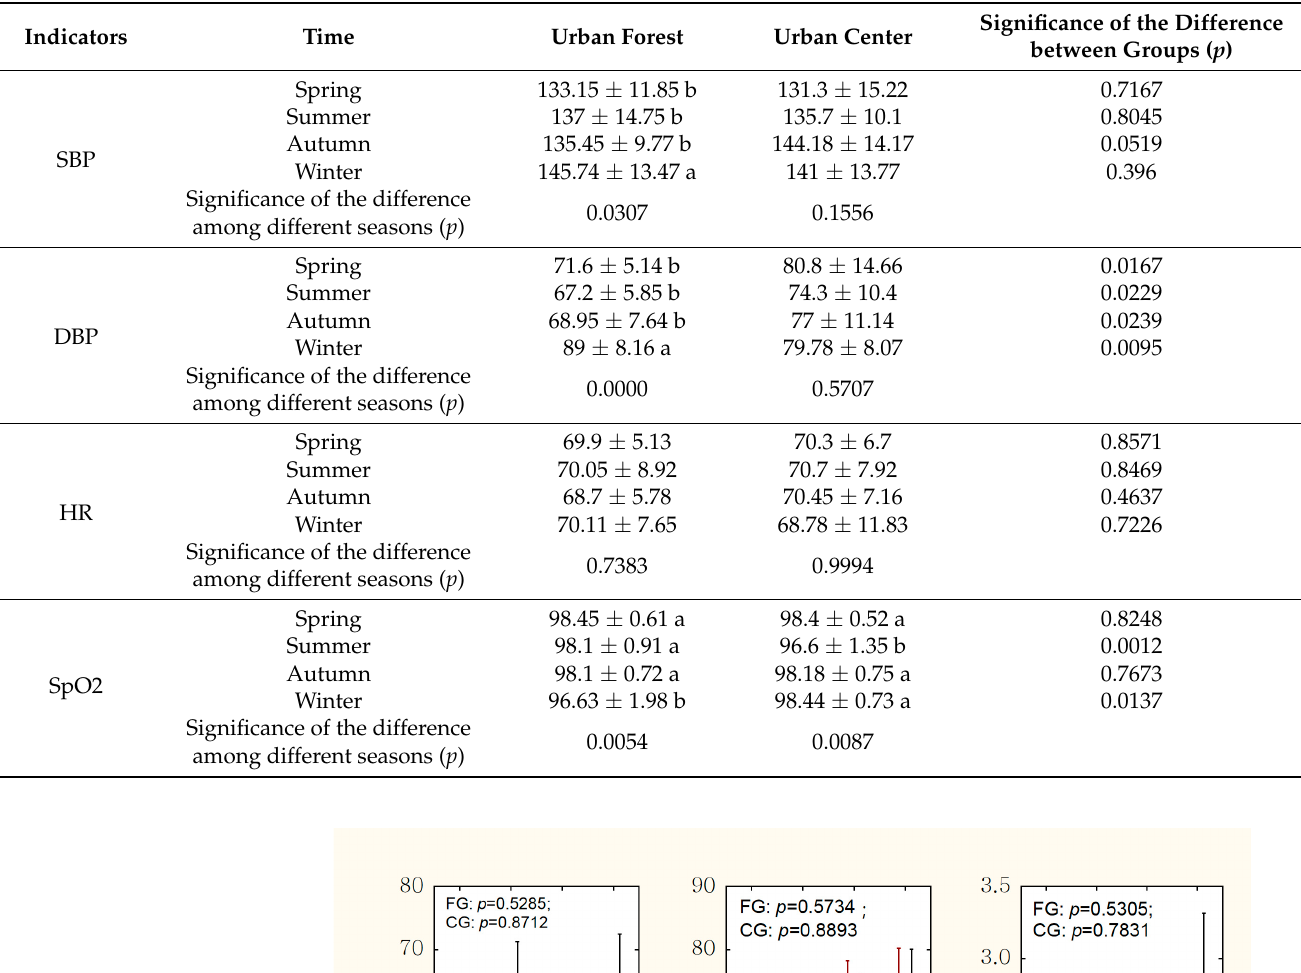
Table 2. Blood pressure indicators of participants among different seasons. Mean values ± standard deviation. Lowercase letters (a, b) in the same column indicate significant differences ( p < 0.05 using Kruskal–Wallis test) among different seasons.